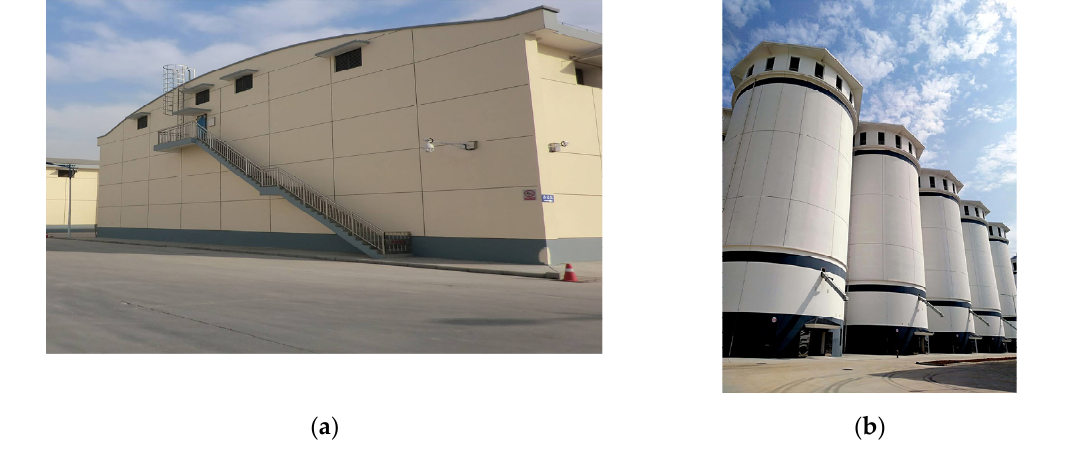
Figure 1. Granary: ( a ) grain bungalow; ( b ) grain silo.